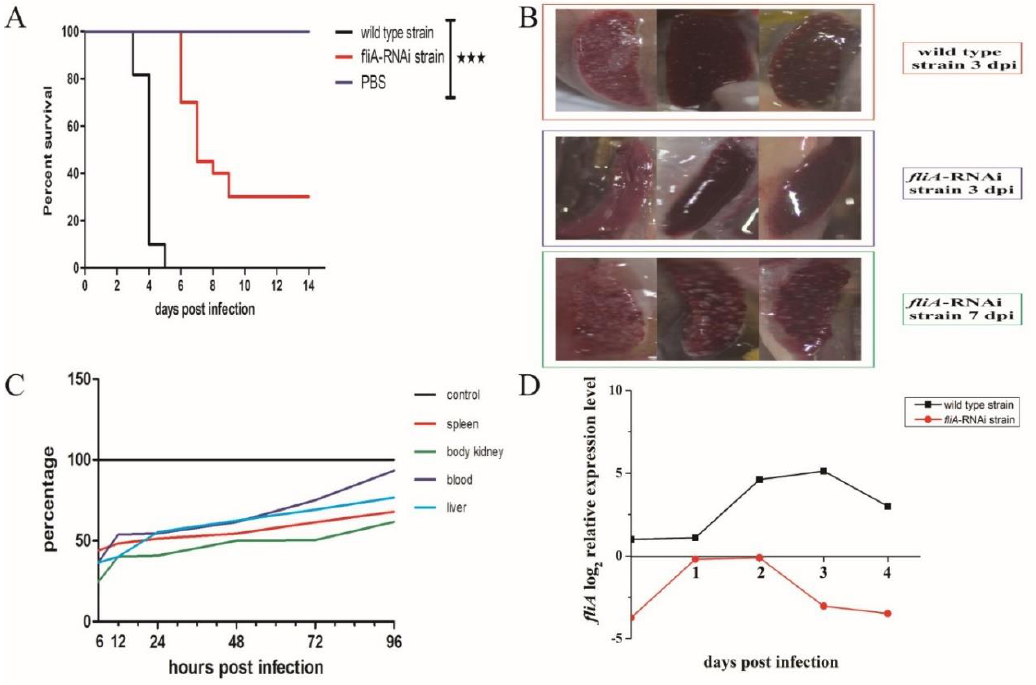
Figure 3. Virulence of the wild type strain and fliA -RNAi strain of P. plecoglossicida . ( A ) Survival curve of L. crocea infected with the wild type strain and fliA -RNAi strain of P. plecoglossicida . ( B ) Appearance of spleens of infected L. crocea. The upper pictures are spleens infected with the wild type strain of P. plecoglossicida , the middle and lower pictures are spleens infected with the fliA -RNAi strain of P. plecoglossicida . ( C ) Spatial and temporal distribution of the fliA -RNAi strain of P. plecoglossicida compared to the wild type strain. Each data point comes from three samples. ( D ) Relative expression of fliA of P. plecoglossicida in L. crocea spleens. Each data point comes from three samples. ★★★ p ≤ 0.001.